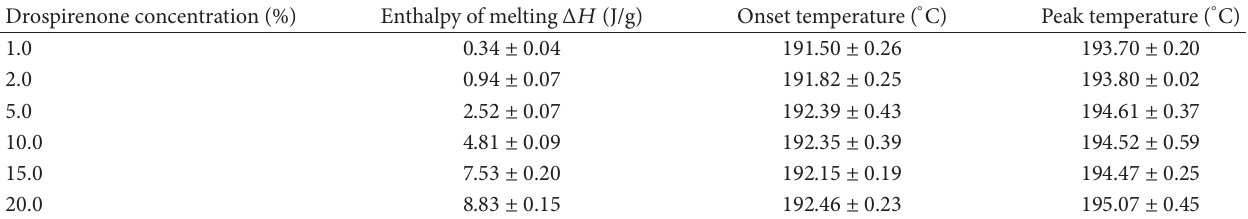
T 3: ermal parameters obtained by differential thermal scanning calorimetry of drospirenone in silicone elastomer